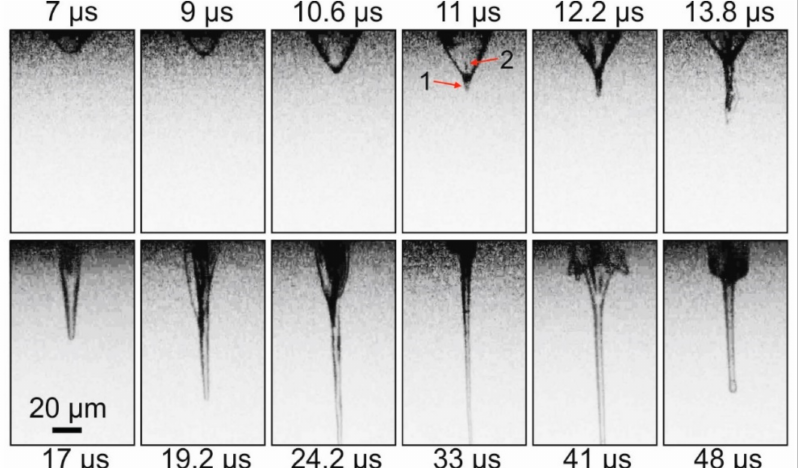
Figure 2. A sequence of frames obtained using time-resolved shadow microscopy during the generation of a vapor–gas bubble and a jet of gel (1.5% hyaluronic acid—see Methods) under the impact of a laser pulse with a duration of τ = 8 ns and an energy of E = 32 µ J on the absorbing Ti layer in Configuration 1 (Figure 1A). Each frame shows the time after exposure to the laser pulse. The arrow (1) points to the jet, arrow (2) points to the counter-jet.